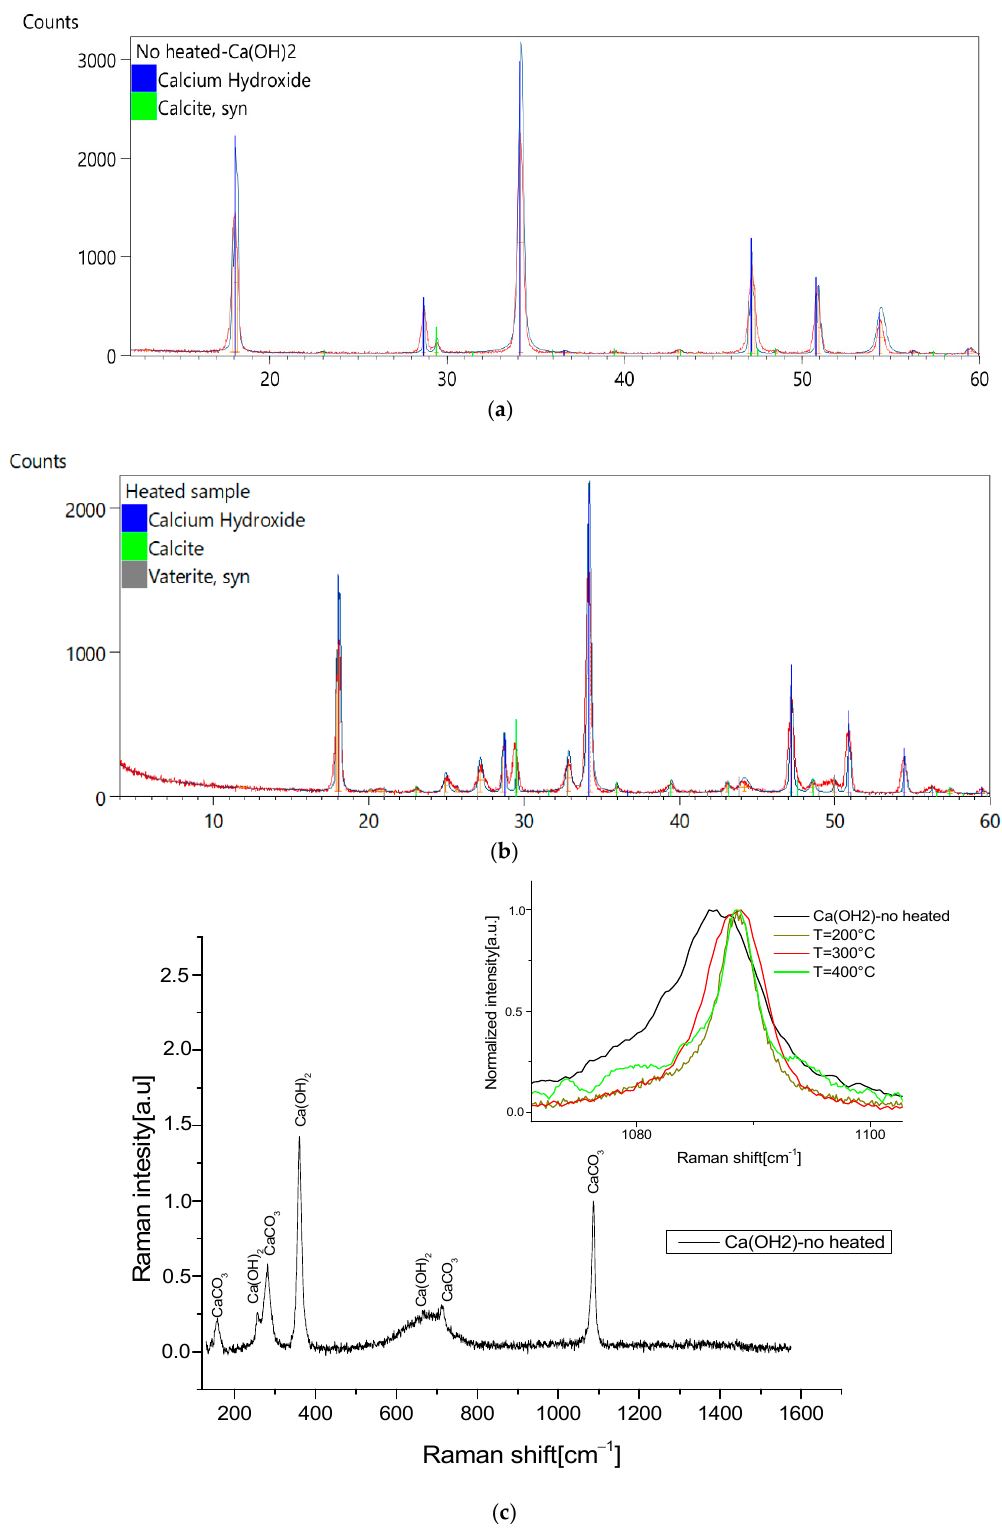
Figure 6. ( a ) XRD pattern of calcium hydroxide after synthesis; ( b ) XRD pattern of calcium hydroxide after 200 °C-heated exposed to air for 20 days; ( c ) 785 nm high resolution Raman spectra of synthesized Calcium hydroxide exposed to air for 20 days; inset, the comparison between the no-heated and heated calcium hydroxide 785-Raman spectra, details of the 1087 cm − 1 band.